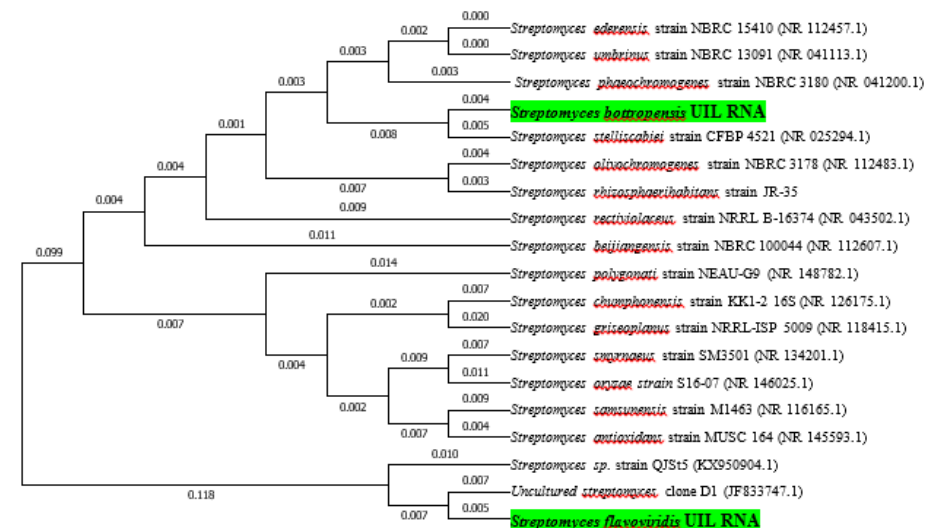
Figure 2. Maximum likelihood tree of the sequenced 16S rRNA gene of the isolated Streptomyces bottropensis strain UIL RNA and Streptomyces flavoviridis strain UIL RNA. The numbers in the branches of the phylogram indicate boostrap value in percentage by 1,000 replication multiples